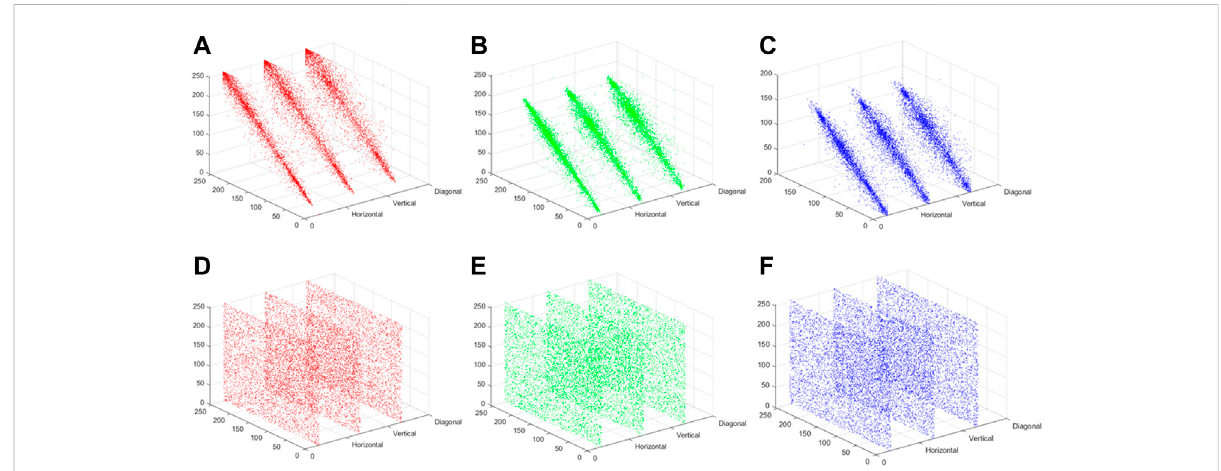
FIGURE 16 Correlationdistributionoftwoadjacenthorizontal,verticalanddiagonalpixelsof “ Girls ” : (A) Rchannel, (B) Gchannel, (C) Bchannel;Correlation distribution of two adjacent horizontal, vertical and diagonal pixels of encryption “ Girls ” : (D) R channel, (E) G channel, (F) B